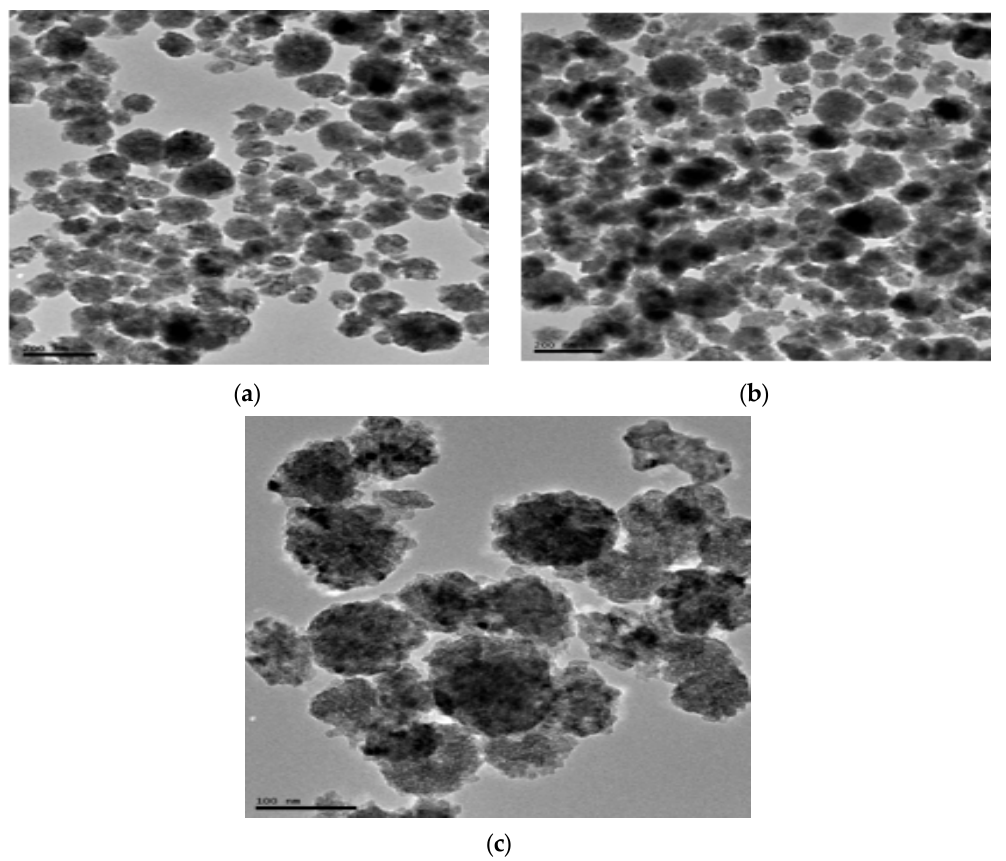
Figure 7. TEM (transmission electron spectroscopy) images for ( a ) CuO-NPs-LA, ( b ) CuO-NPs-TA, and ( c ) CuO-NPs-OA from lemon, tangerine and orange extracts, respectively, using acetone as